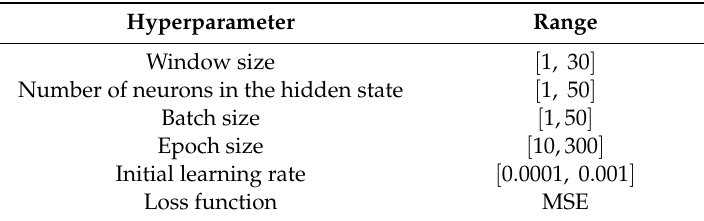
Table 1. The range of hyperparameters of Gated Recurrent Unit.